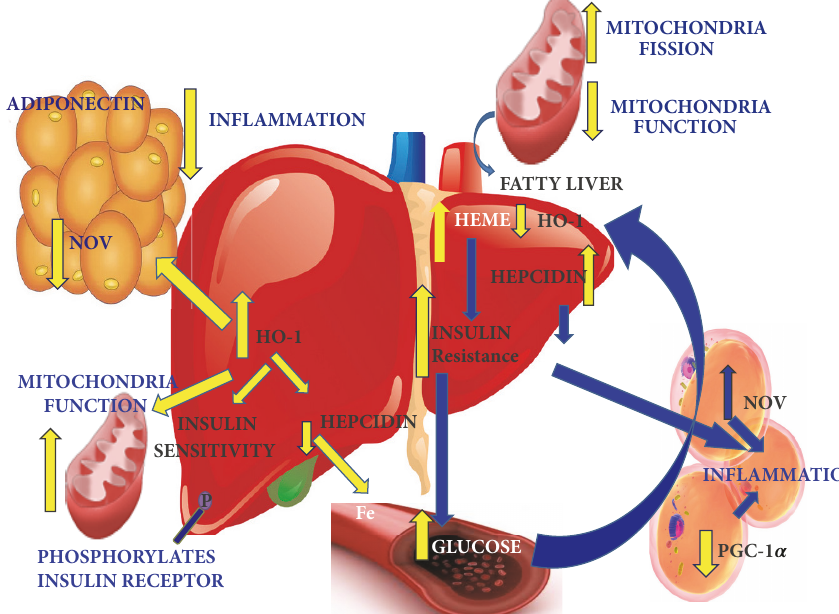
Figure 8: Schematic description of the HO-1 mediated induction of adipose tissue of HF fed mice. As seen in right side panel, decreased HO-1 resulted in an increase of hepatic heme, hepcidin, which is associated with the development and progression of obesity-induced NASH, fibrosis via mitochondrial dysfunction (fission and decreases in COX 2 and 4). Fat expansion was associated with remodeling marked by an increase in adipocyte hyperplasia and hypertrophy leading to proinflammatory molecule NOV, which is associated with a decrease of PGC- 1 𝛼 and insulin receptor phosphorylation and eventually development of fibrosis and NAS. In the left panel, induction of HO-1 reduced the severity of steatosis, inflammation, and fibrosis through decrease in NOV and an increase of adiponectin that resulted in the improvement of hepatic mitochondrial integrity, pAMPK-pAKT, and insulin receptor phosphorylation that all in concert leads to an improvement in hepatic function and